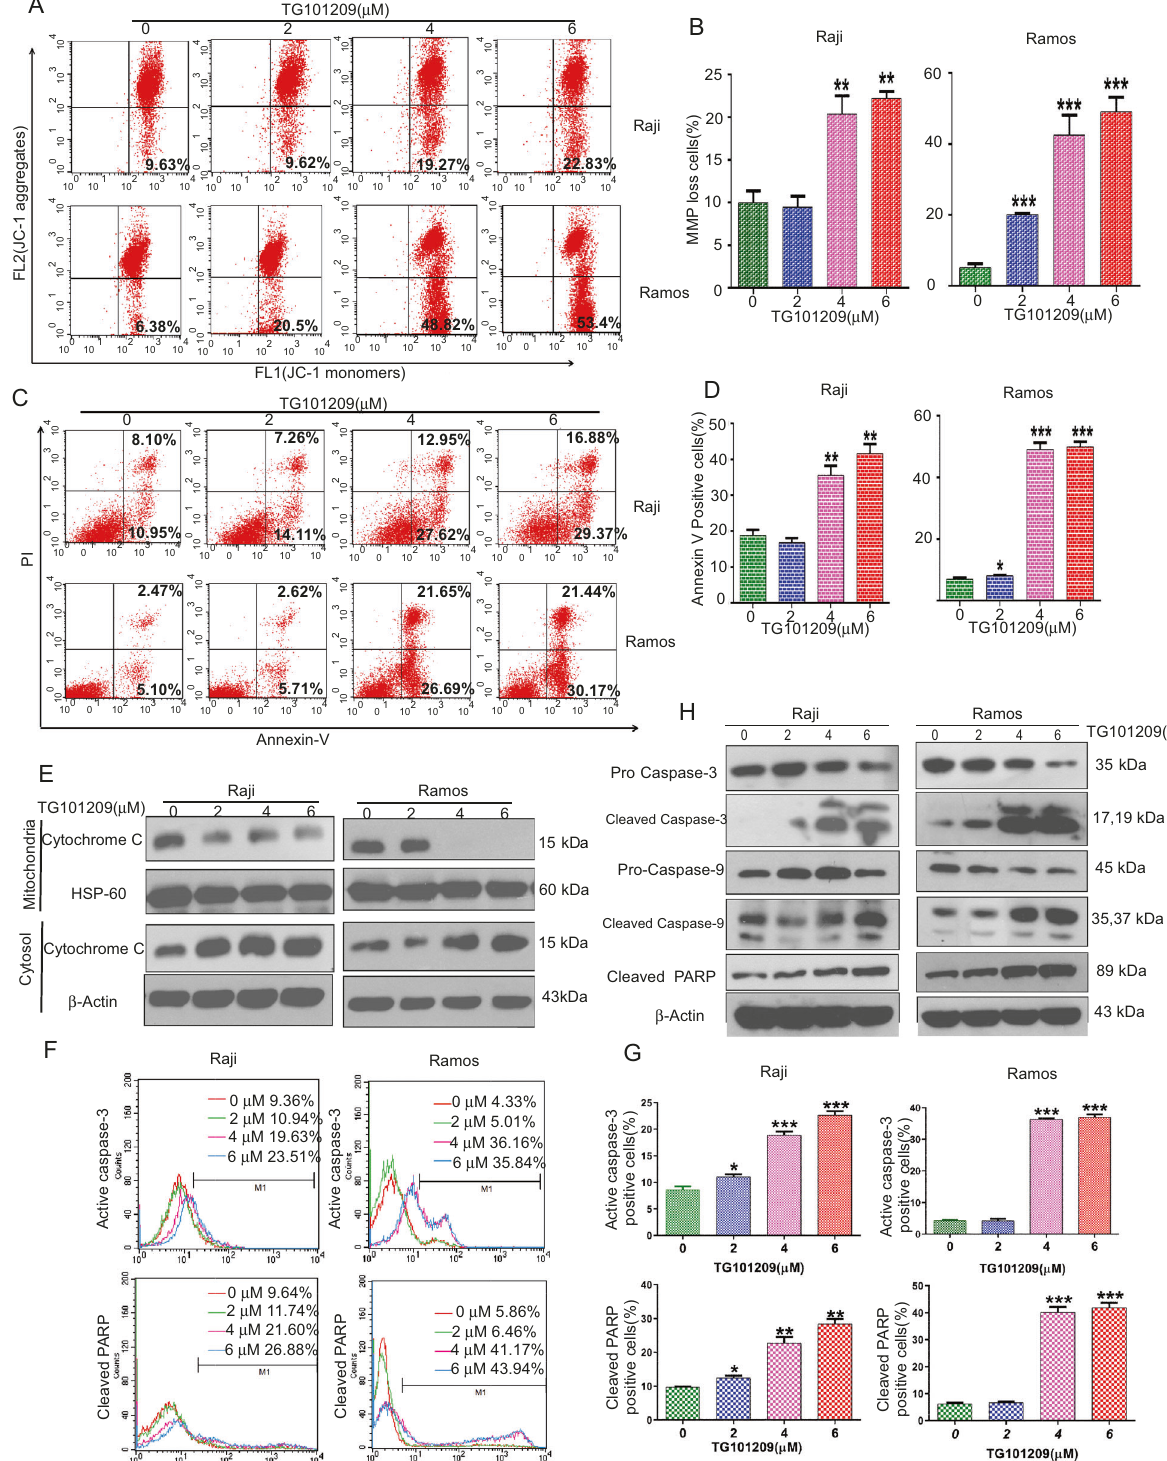
Fig. 2 TG101209 induces BL cell apoptosis by a mitochondrial-mediated caspase-dependent pathway. The BL cells were treated with the indicated concentrations of TG101209 for 48h, then the cells were determined by fl ow cytometry analysis. A The mitochondrial